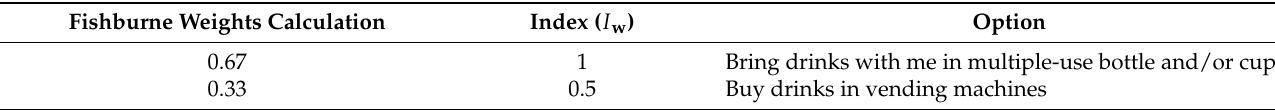
Table 10. Index system for type of meat consumption.